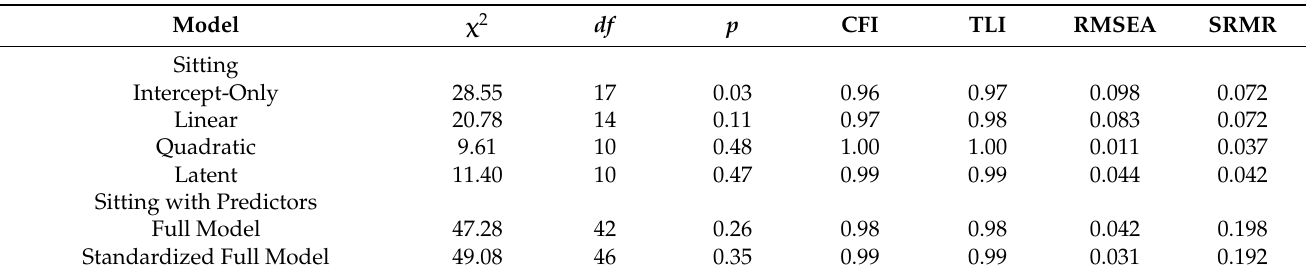
Table 3. Model fit estimates of latent growth model analyses.